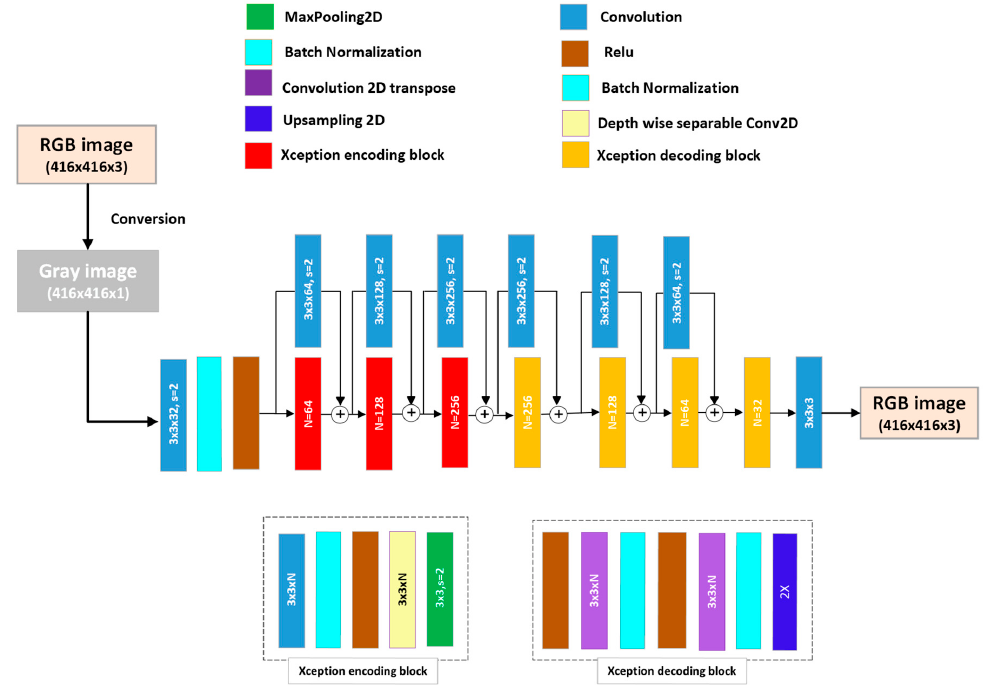
Figure 2. Xception–UNet convolutional neural network (CNN) architecture. The architecture consists of three encoding blocks in the encoder part and four decoding blocks in the decoder part. Below the architecture are detailed drawings of the encoding and decoding blocks.